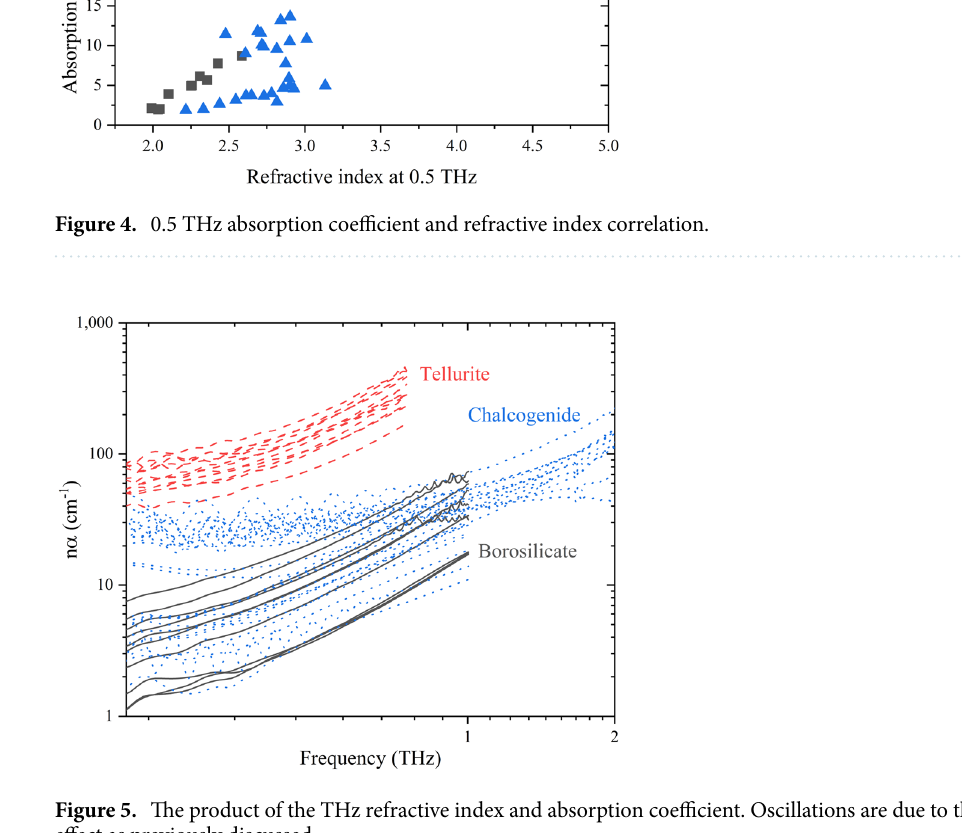
Figure 5. The product of the THz refractive index and absorption coefficient. Oscillations are due to the etalon effect as previously